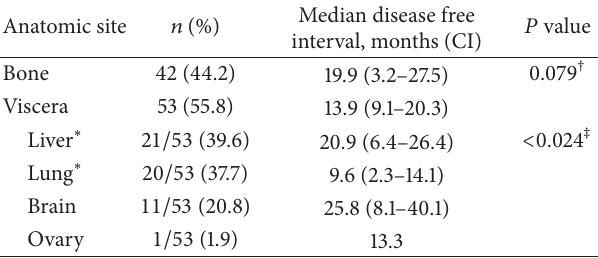
Table 2: First site of distant metastases and median disease free interval in 95